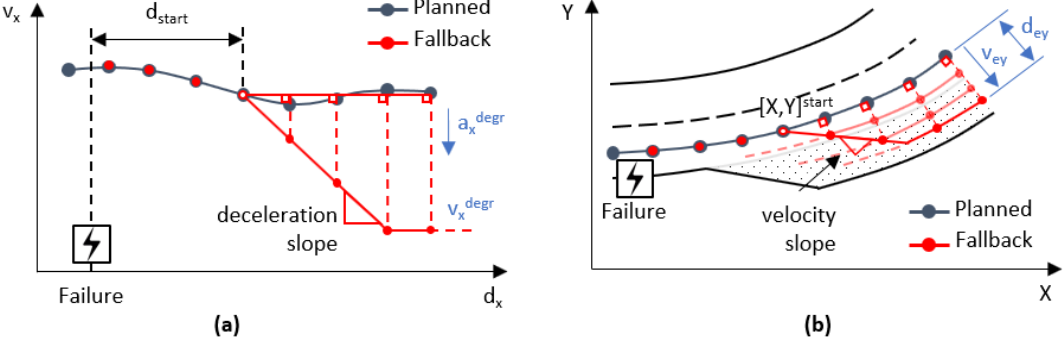
Figure 4. Real-time trajectory planning for ( a ) velocity and ( b )